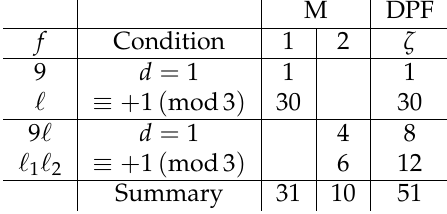
Multiplicity Differential Principal Factorization